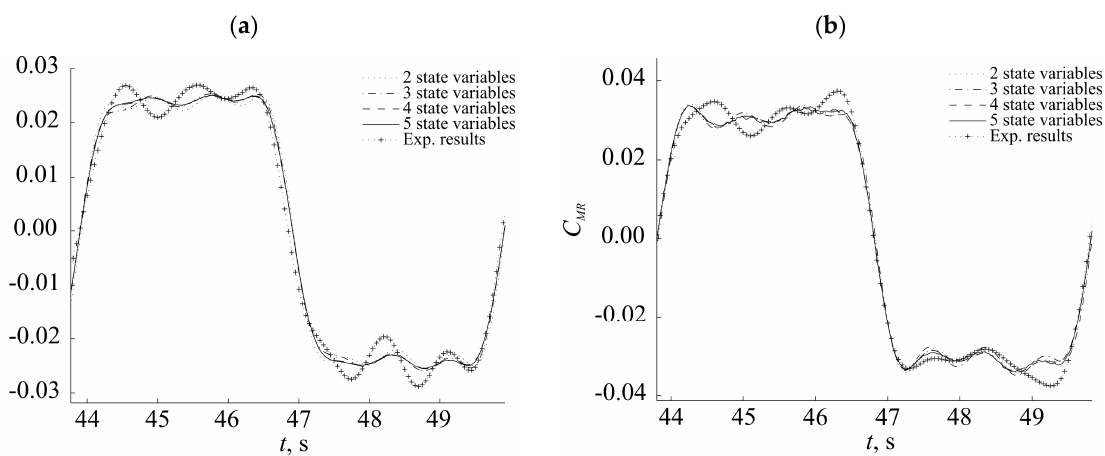
Figure 8. Time history of the overturning moment coefficient; comparison of measured data against calculated time response for two-, three-, four- and five-state variable models for: ( a ) model A and ( b ) model B.